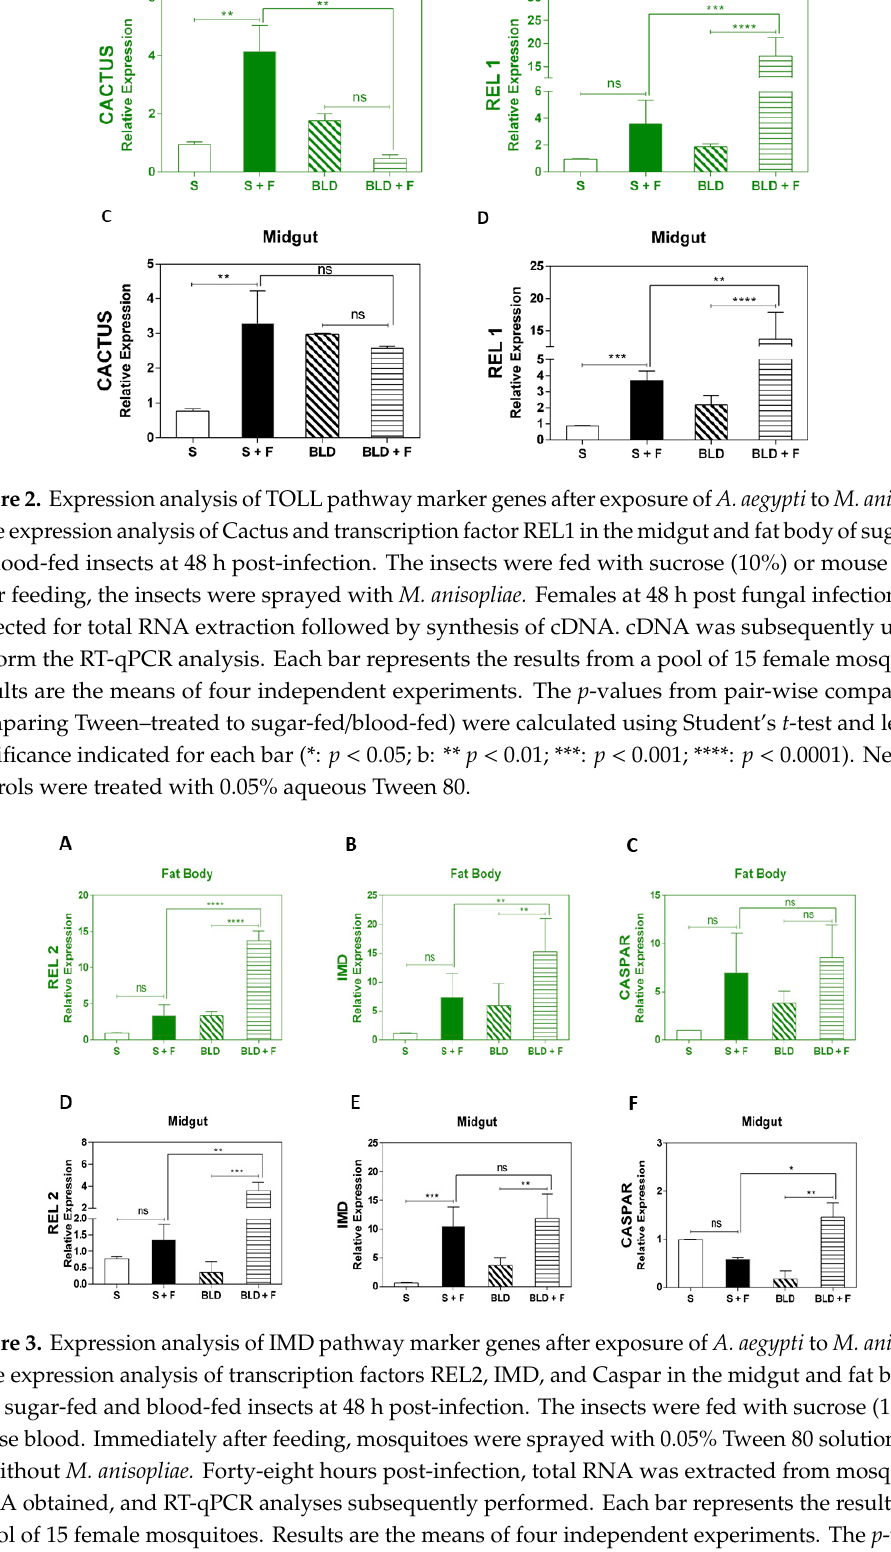
Figure 4. Expression analysis of the JAK-STAT pathway marker genes after exposure of A. aegypti to M. anisopliae . Gene expression analysis of PIAS, and signal transducer and activator of transcription STAT both in the midgut and fat body of sugar-fed and blood-fed mosquitoes at 48 h post infection.